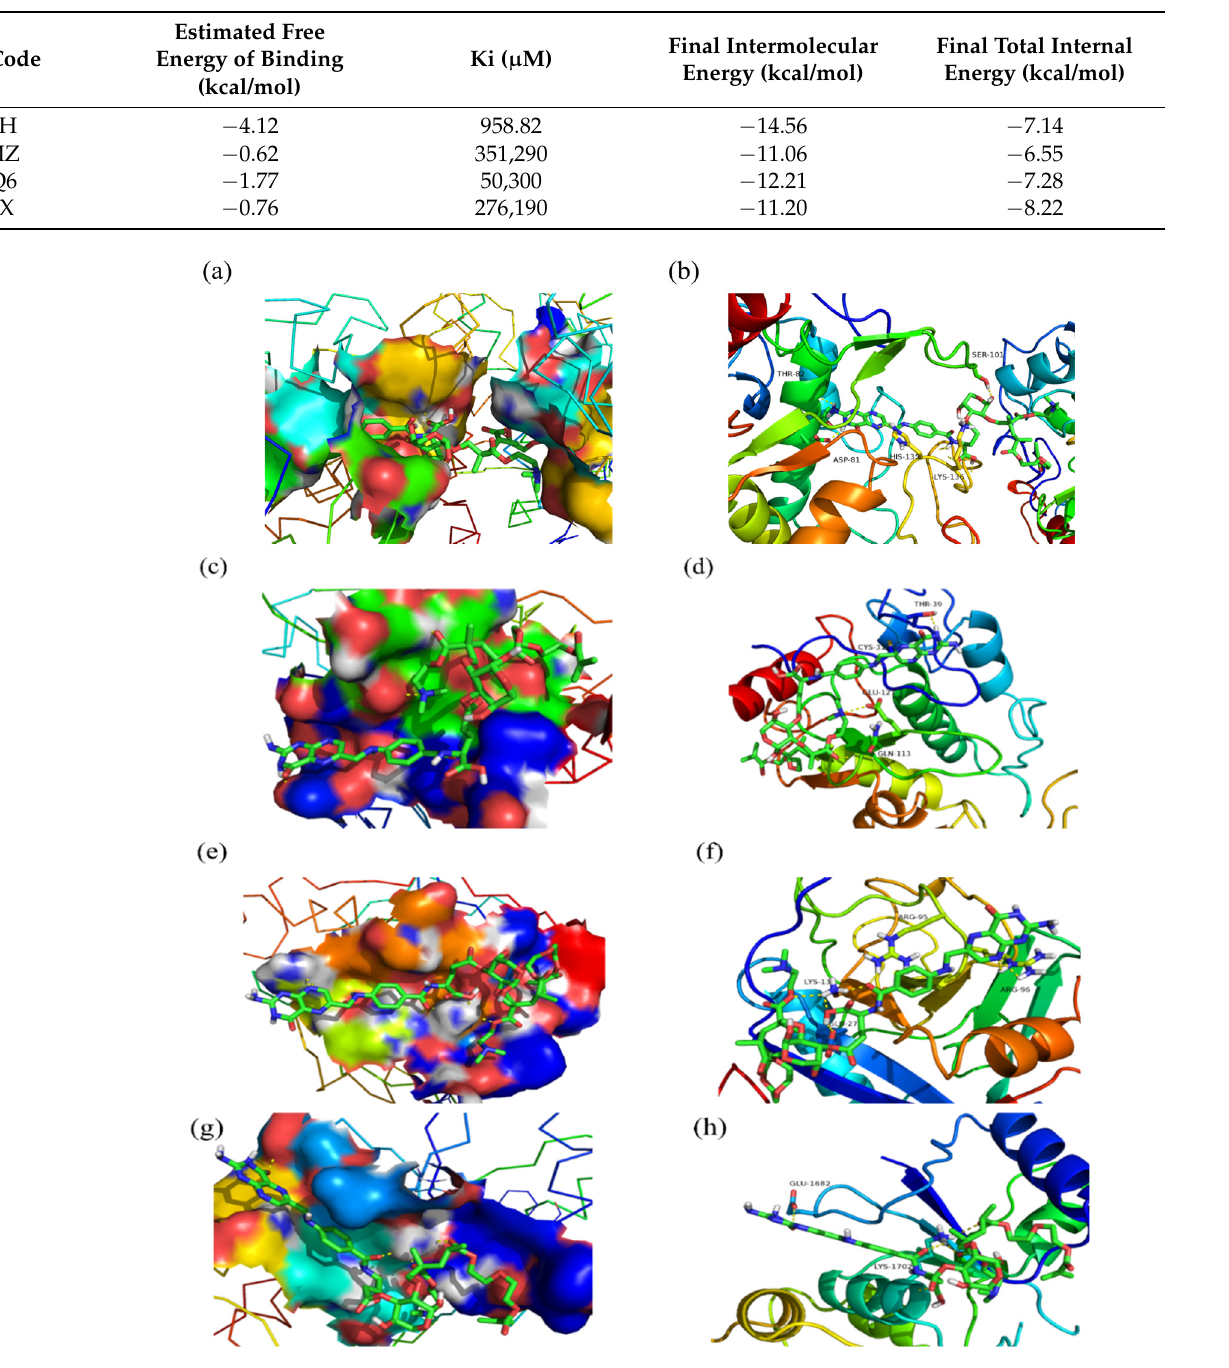
Figure 6. ( a ) BA F G 2 and 4LRH docking conformation. ( b ) The docking site of BA F G 2 within the active site of 4LRH. ( c ) BA F G 2 and 4KMZ docking conformation. ( d ) The docking site of BA F G 2 within the active site of 4KMZ. ( e ) BA F G 2 and 2HQ6 docking conformation. ( f ) The docking site of BA F G 2 within the active site of 2HQ6. ( g ) BA F G 2 and 1JNX docking conformation. ( h ) The docking site of BA F G 2 within the active site of 1JNX.